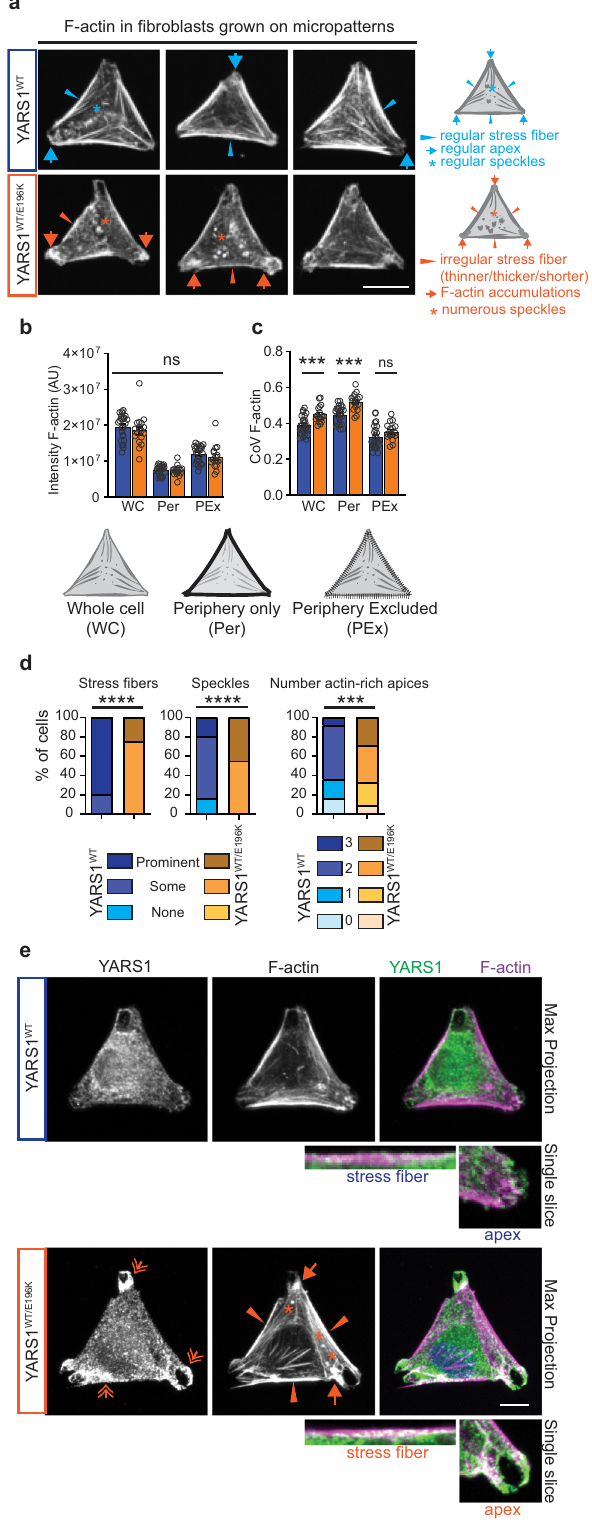
Neuronally expressed PLS3 had a comparable distribution pattern (Supplementary Fig. 9e, f). In contrast, no major overlap was observed between YARS1 and the active zone marker Bruchpilot (Brp), or the periactive zone marker FasII (Supplementary Fig. 11b, c).